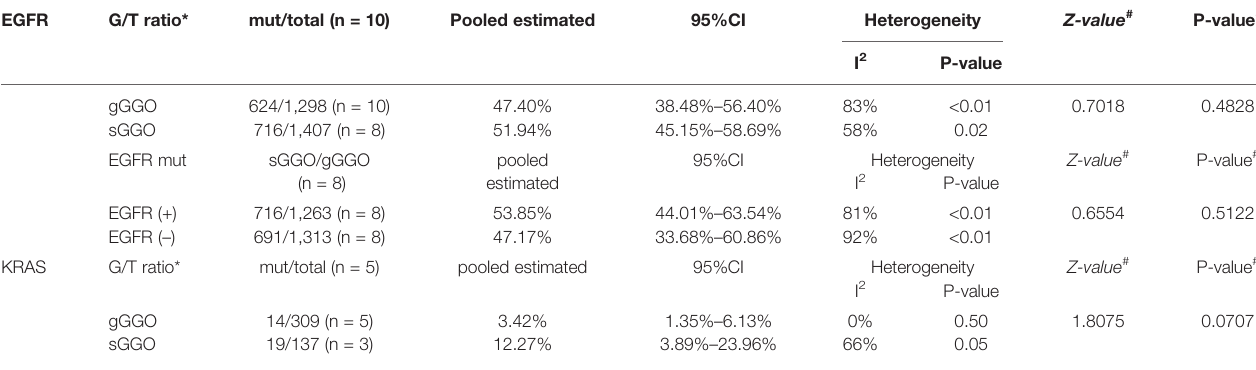
TABLE 2 | Details of the radiological subgroup analysis for the EGFR mutation and KRAS mutation by the random effect model. EGFR G/T